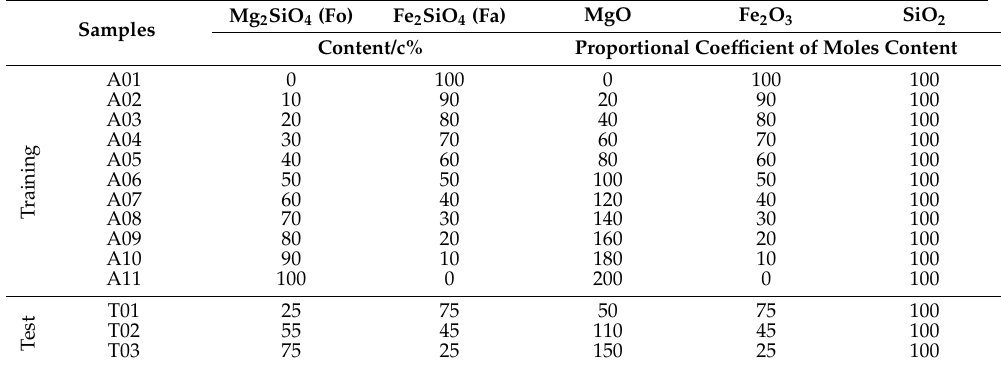
Table 2. End-number for the samples and